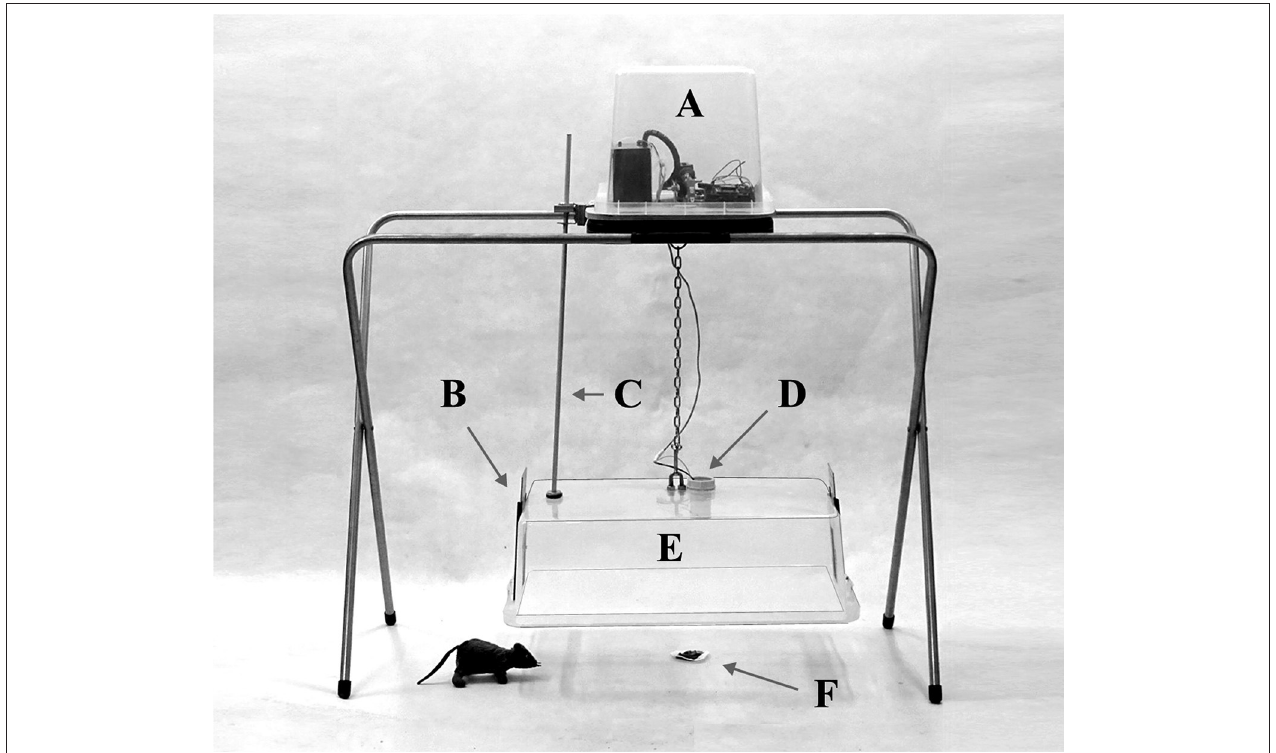
FIGURE 1 | The tested prototype of the trap: (A) Arduino computer and triggering mechanism; (B) upward-sliding entrance gate used for taking the animals out of the trap; (C) bar preventing the transparent cover from moving and rotating; (D) motion detector with regulated range and sensitivity; (E) falling transparent cover made of plastic; (F)